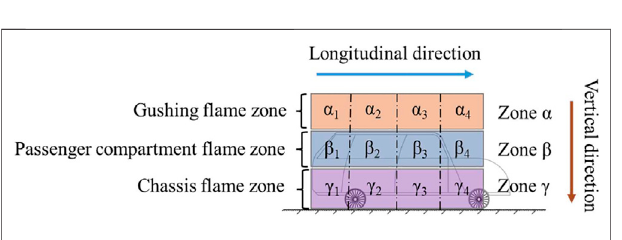
FIGURE 6 | Fire zones of the